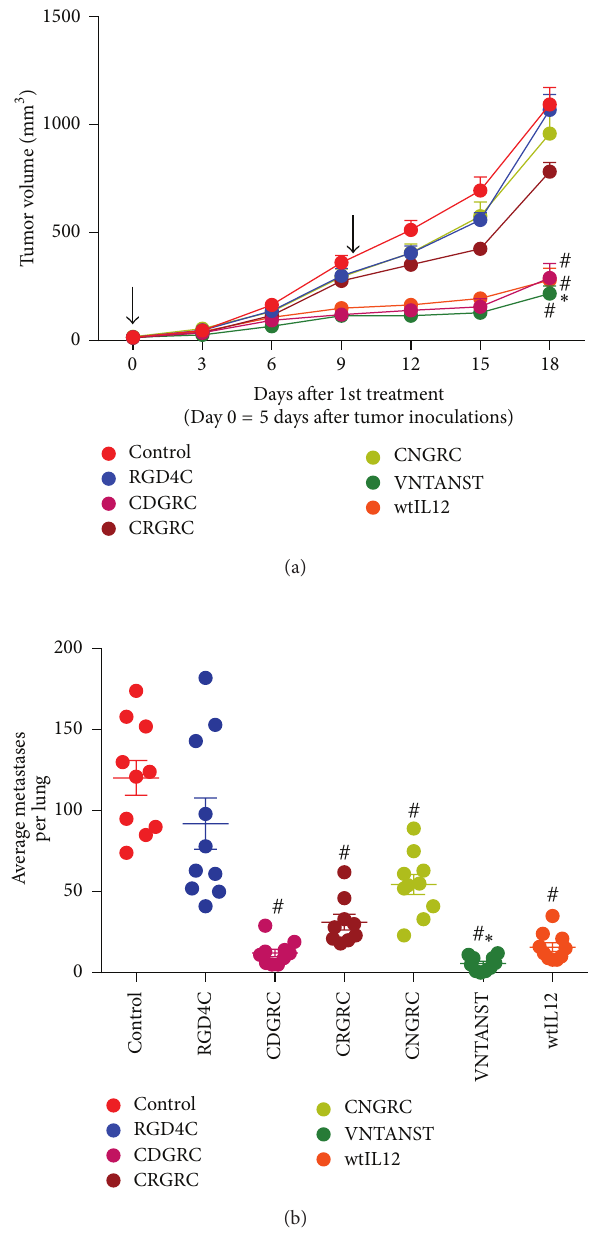
Figure 5: Not all tumor-targeting peptides can be successfully utilized in this gene delivery method. (a) Multiple tumor-targeting IL12 pDNAs were created by inserting the tumor-targeting peptide- coding sequences into the p40 subunit of the IL12 pDNA as in Figure 1(a). Only the wtIL12, VNTANST-IL12, and CDGRC-IL12 pDNA treatments inhibited primary tumor growth compared to the control pDNA treatments in the 4T1 tumor model. In side-by-side statistical analyses, the inhibition of primary tumor growth with VNTANST-IL12 was significantly inhibited compared to the wtIL12 and CDGRC-IL12 data on day 18 only. (b) Similar results were seen in the development of metastatic tumors in the same mice with onlyRGD4Cnotreducingdevelopmentcomparedtocontrol.Again, VNTANST-IL12 was significantly different from all groups in side- by-side analyses. Black arrows represent treatments. # represents 𝑃 < 0.05 compared to control. ∗ represents 𝑃 < 0.05 compared to all other groups.